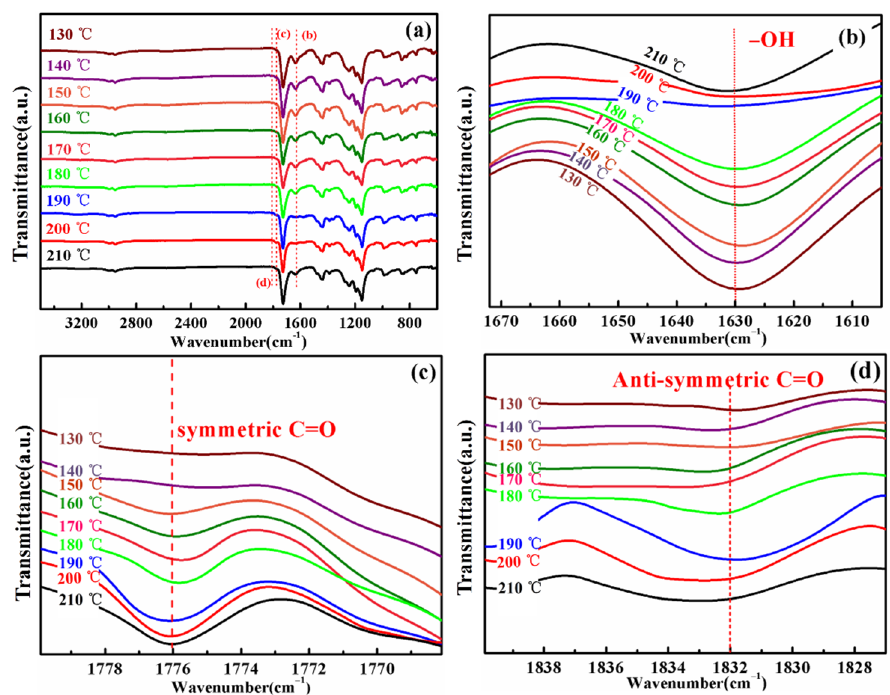
Figure 4. FTIR spectra of the coatings cured at different temperatures in the range of ( a ) 3600–600 cm − 1 , ( b ) 1670–1610 cm − 1 , ( c ) 1780–1768 cm − 1 , and ( d ) 1840–1827 cm − 1 .